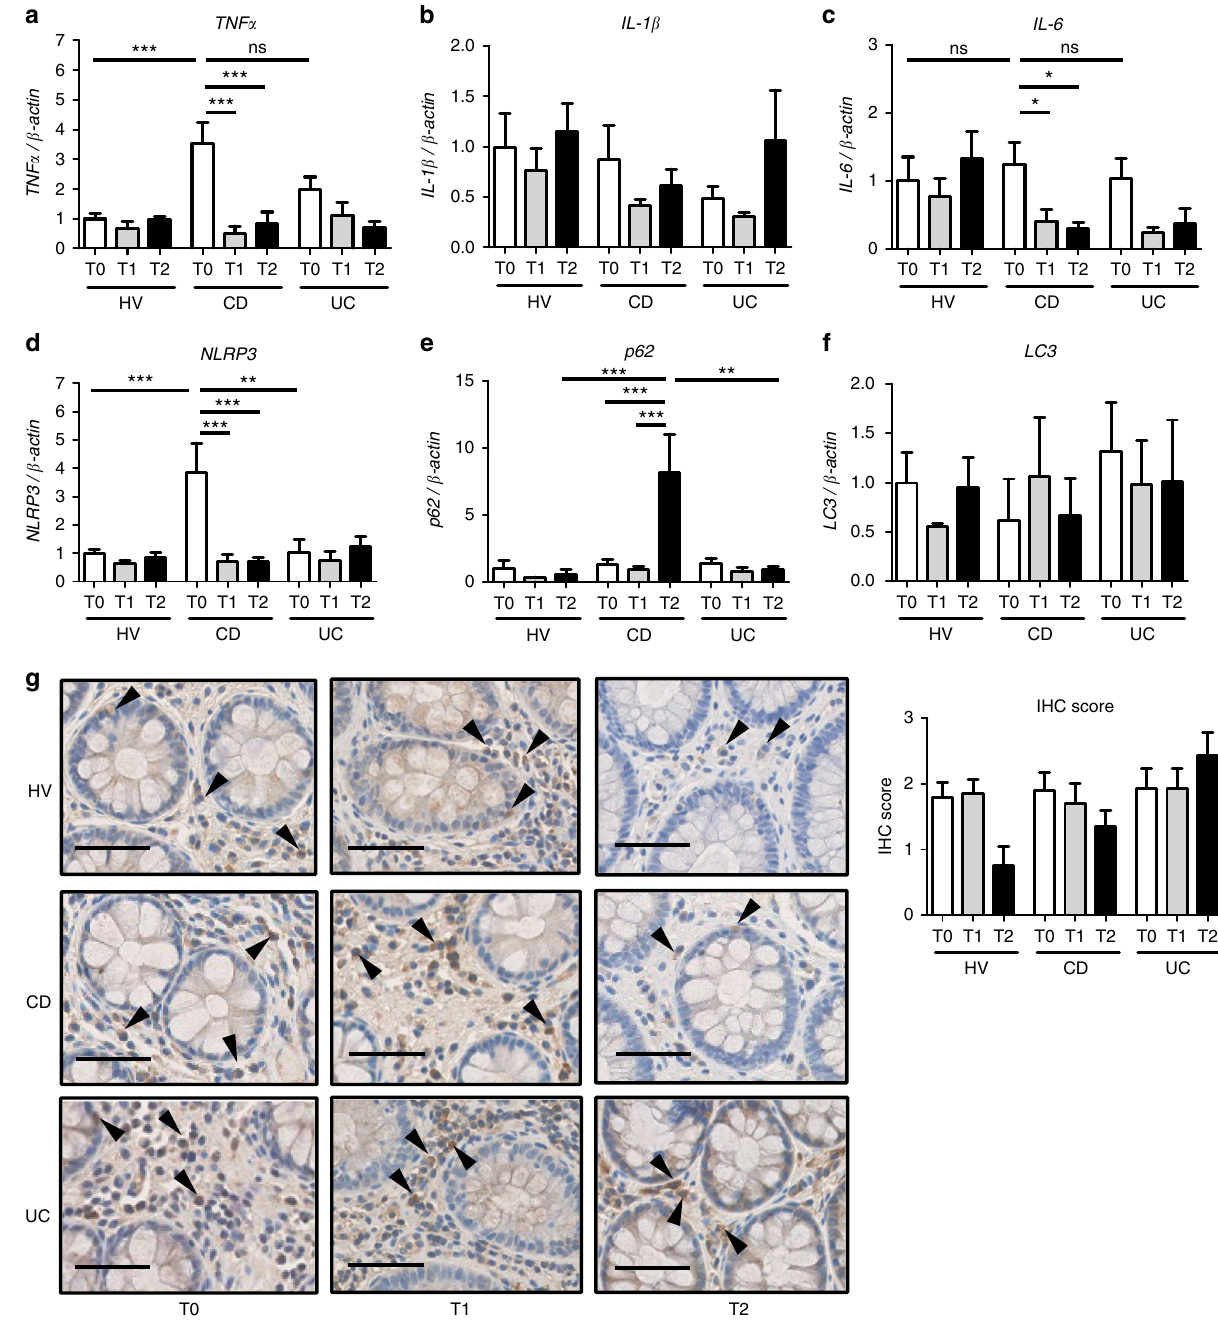
Fig. 1 Hypoxia reduces in fl ammatory gene expression and induces autophagy fl ux in CD patients. a , b , c , d , e , and f Healthy volunteers ( HV , n = 10), patients with Crohn ’ s disease ( CD , n = 11) and patients with ulcerative colitis ( UC , n = 9) were subjected to hypoxic conditions in a hypobaric chamber simulating an altitude of 4000 m.a.s.l. for 3 h. Distal colon biopsies were taken the day before entering the hypobaric chamber (T0), immediately after hypoxia (T1), and 1 week after collection of the fi rst biopsy (T2), and transcript analysis was performed. Statistical analysis was performed using one-way ANOVA followed by Tukey ’ s post-test. Results represent mean + s.e.m.,* P < 0.05; ** P < 0.01; *** P < 0.001; ns = not signi fi cant. g Immunostaining for p62 ( arrowheads ) was performed on distal colon sections and immunohistochemistry (IHC) score was determined by two independent, blinded investigators. Scale bar, 25 µ